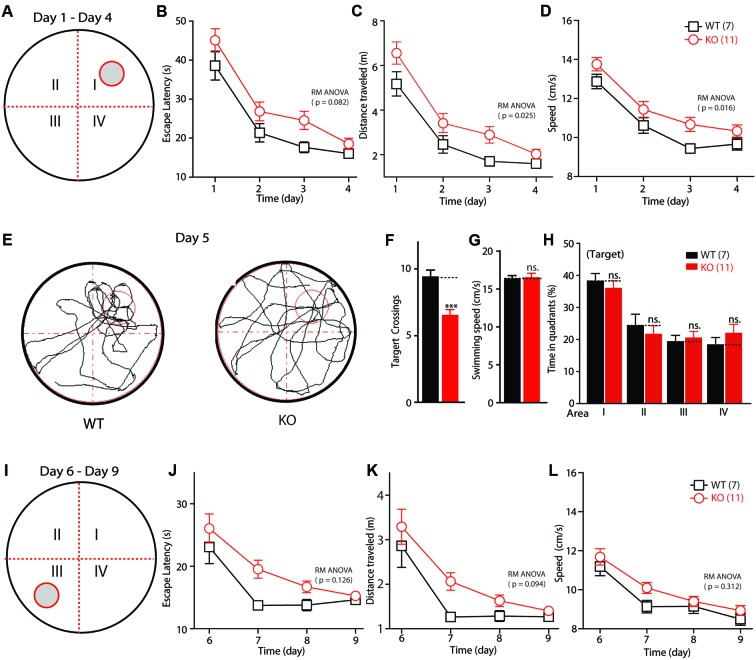
Impaired spatial learning and memory in Fmr1 KO rats in the Morris water maze. (A) Schematic diagram of the apparatus. (B) Plot of escape latency. (C) Plot of travel distance. (D) Plot of swimming speed required for the rats to find the visible platform during the learning phase. (E) Representative movement traces. The empty red circles (left) indicate the location of the former platform, which was removed in the probe test. (F) Summary of the number of crosses of the former platform area. (G) Swimming speed in the probe test. (H) Time in each quadrant during the probe test (p < 0.001 target quadrant vs. Q2, Q3, or Q4). (I) Schematic diagram of the apparatus. The visible platform was placed in the third quadrant, which was opposite to that used during the learning phase (the first quadrant). (J) Plot of escape latency. (K) Plot of travel distance. (L) Plot of swimming speed required for the rats to find the visible platform during the reverse learning phase. All data are presented as mean ± SEM. Repeated-measures analysis of variance (RM ANOVA) was used to evaluate the difference between the two curves in (A–D) and (J–L). Student’s t-test was used to compare the two groups (F,G). Post hoc analysis was used to analyze the statistically significant ANOVA results (H) (∗∗∗p < 0.001; ns., not significant).